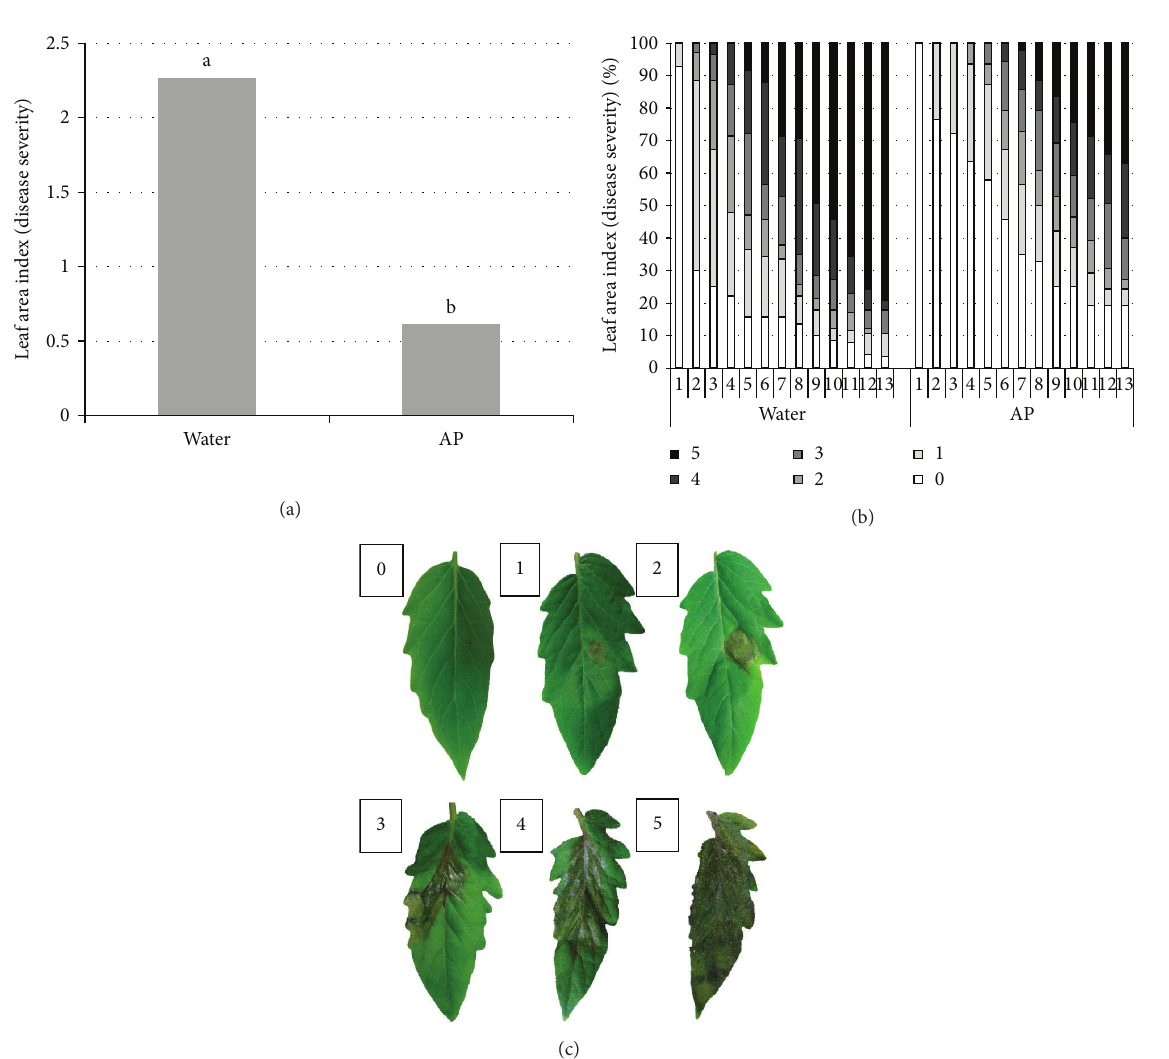
Figure 3: Plant pathogen ( S. lycopersicum cv. House Momotaro— B. cinerea ) interaction in the presence of algal product (AP) elicitor. Tomato (HM) plants were spray-washed with AP (1%) or H 2 O and inoculated with 15 𝜇 L of B. cinerea spores (10 5 spore/mL) 1 day later, and disease development was evaluated daily from the first dpi until the 13th dpi. (a) Average disease severity evaluated 5dpi. Different letters indicate significant differences at ( 𝑃 < 0.01 ). (b) Percentages of infected S. lycopersicum leaves and disease symptom severities of the AP- and H 2 O- treated plants from 1st until the 14th dpi. Disease severity was quantified in reference to (c). (c) Development of B. cinerea on S. lycopersicum leaves was marked from 0 (if the leaf was not infected) to 5 (if the leaf was fully infected) and this reference was made for this purpose accordingly. Three plants were used in each experiment. Results are the average of three repeated